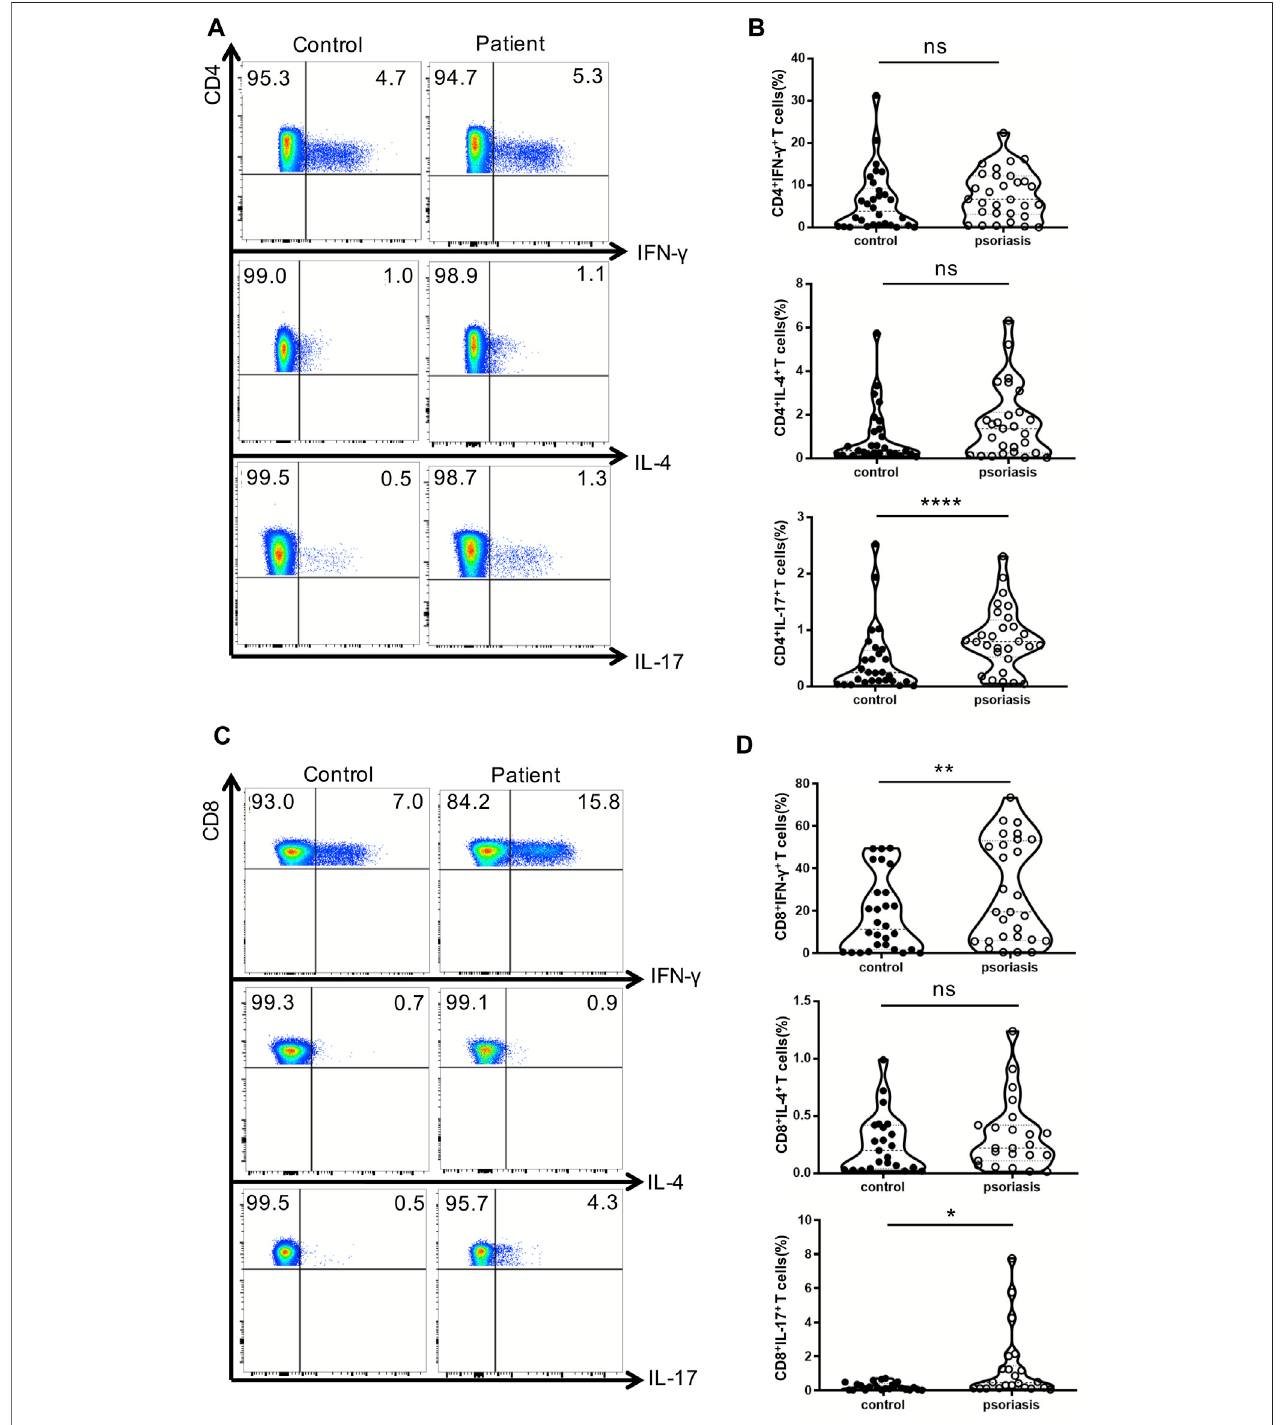
FIGURE 2 | Cytokine-producing T cells from peripheral blood. PBMCs isolated from moderate-to-severe plaque psoriasis patients and healthy controls were stimulated with Cell Stimulation Cocktail for 5 h. The IFN- γ -, IL-4- and IL-17-producing T cells were determined by intracellular staining and fl ow cytometry analysis. (A) The proportion of IFN- γ – ,IL-4- and IL-17-producing CD4 + T cells in psoriasis patients versus healthy controls. (B) Summary plots showing individual results of the frequency of IFN- γ – ,IL-4- and IL-17- producing CD4 + T cells in psoriasis patients versus healthy controls. (C) The proportion of IFN- γ – ,IL-4- and IL-17-producing CD8 + Tcellsinpsoriasispatientsversushealthycontrols. (D) SummaryplotsshowingindividualresultsofthefrequencyofIFN- γ -,IL-4-andIL-17-producingCD8 + Tcells in psoriasis patients versus healthy controls. Data show mean +SEM. p -values were determined by paired Student ’ s t-test. ns, no signi fi cance, * p < 0.05, ** p < 0.01, *** p < 0.001 and **** p < 0.0001.